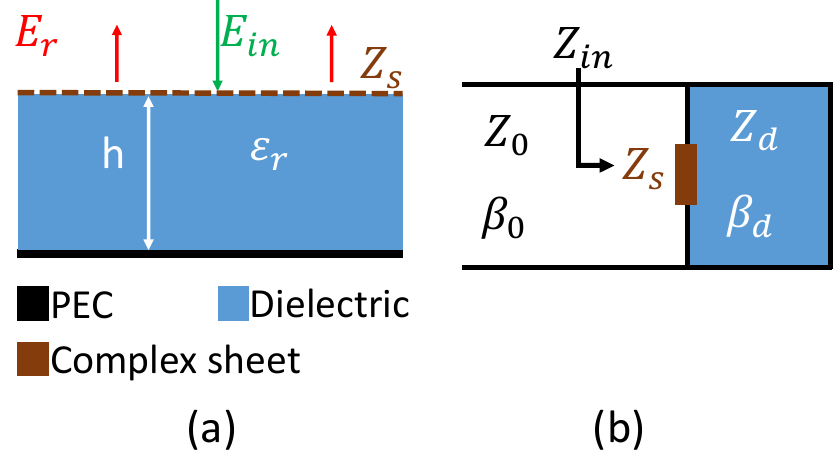
Figure 4. ( a ) Schematic design of a radar absorber, ( b ) Transmission line model of the